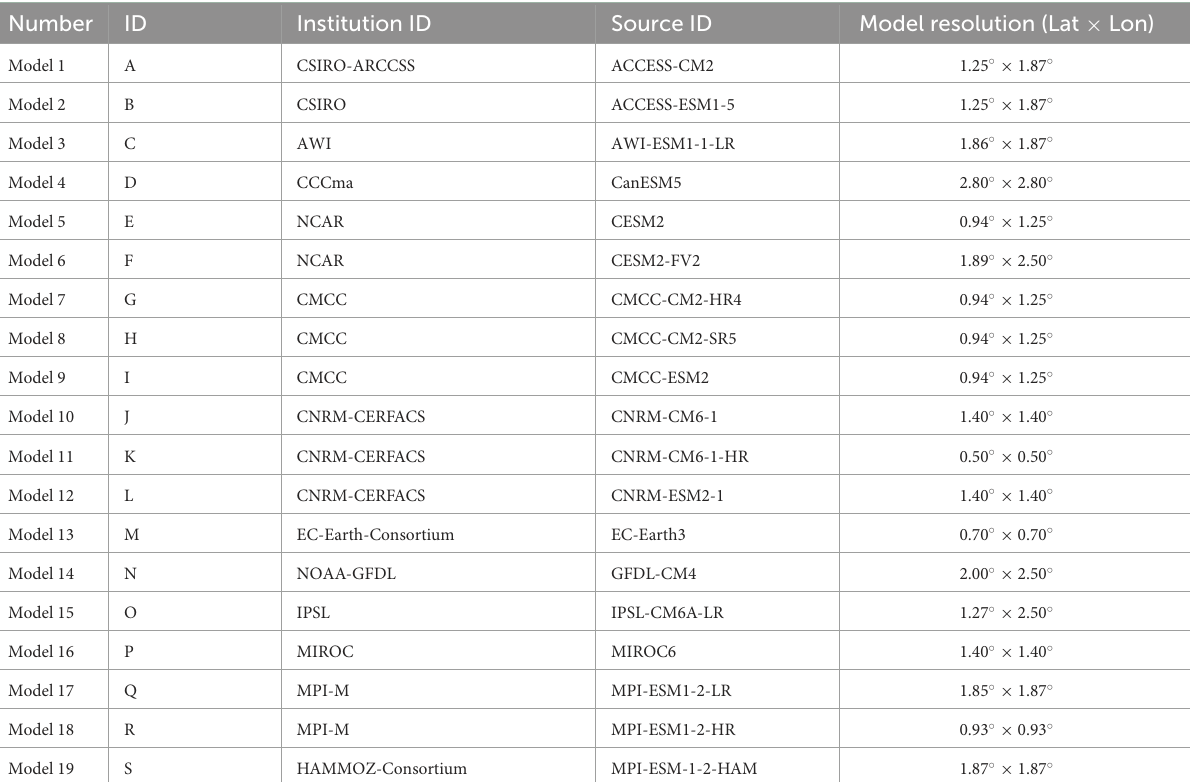
TABLE 1 Nineteen selected CMIP6 climate models used for the analysis in this